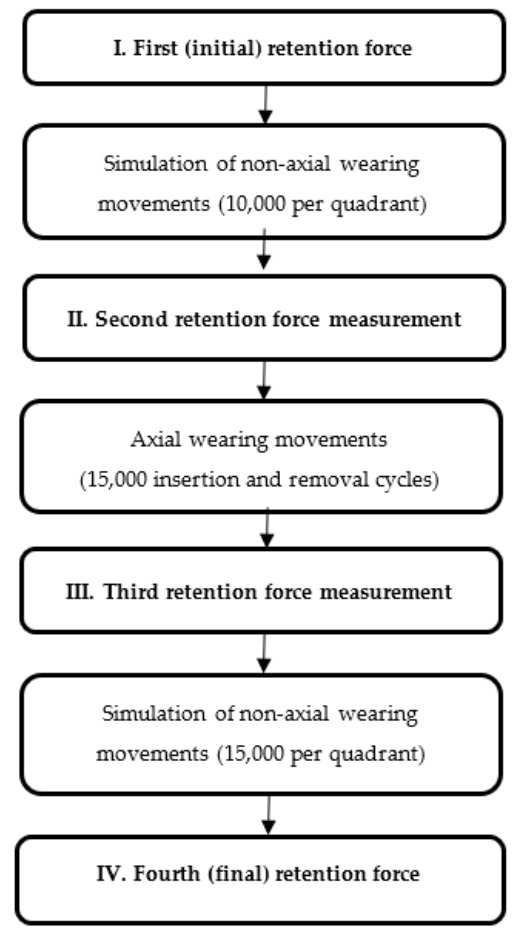
Figure 2. Test procedure. After initial retention force measurement, non-axial wearing movements were simulated (10,000 cycles per quadrant) followed by second retention force measurement. Afterwards, axial loading was simulated in a universal testing machine (15,000 cycles) followed by third retention force measurement. The final retention force measurement was performed after another simulation of non-axial wearing (15,000 cycles per